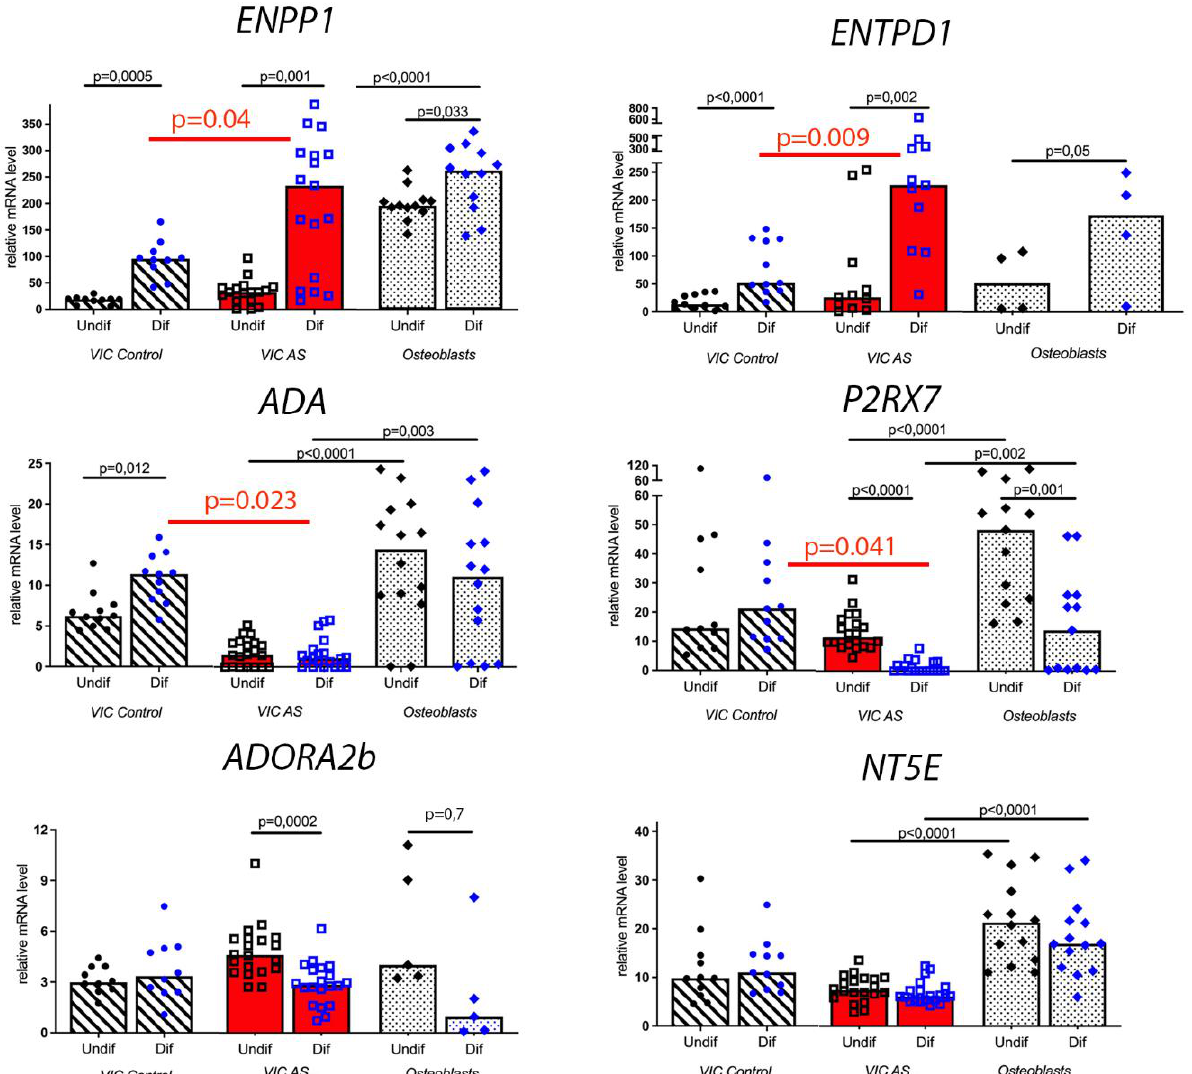
Figure 2. Expression levels of ENPP1, ENTPD1, ADA, P2RX7, ADORA2b and NT5E in valve interstitial cells (VIC) and osteoblast-like cells. Relative mRNA levels in non-stenotic VICs (VIC Control) are compared with stenotic VICs (AS VIC); relative mRNA levels in stenotic VICs are compared with osteoblast-like cells (Osteoblasts). Relative mRNA levels in undifferentiated cells (Undif) are compared with cells in which osteogenic differentiation (Dif) was induced.